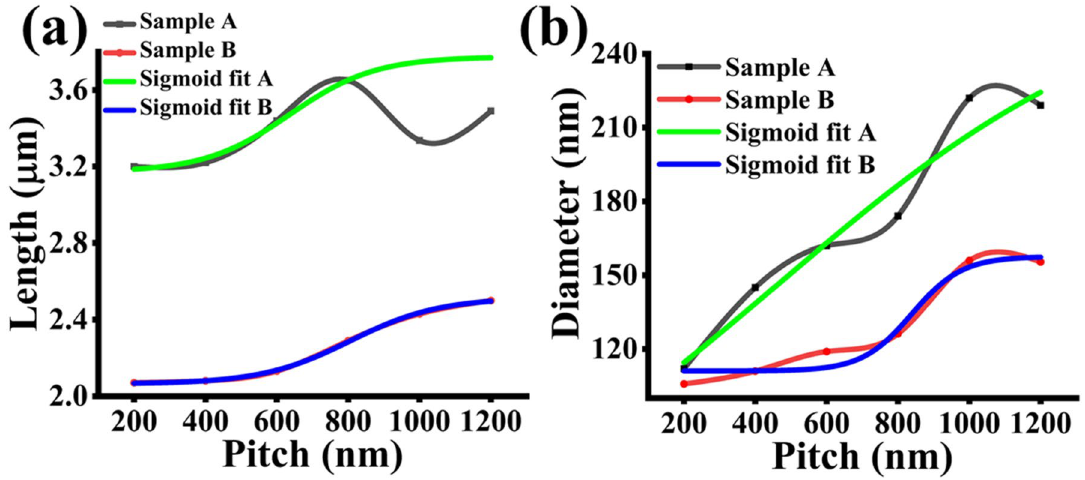
Figure 9. Sigmoidal fit results for ( a ) length and ( b ) diameter in both samples A and